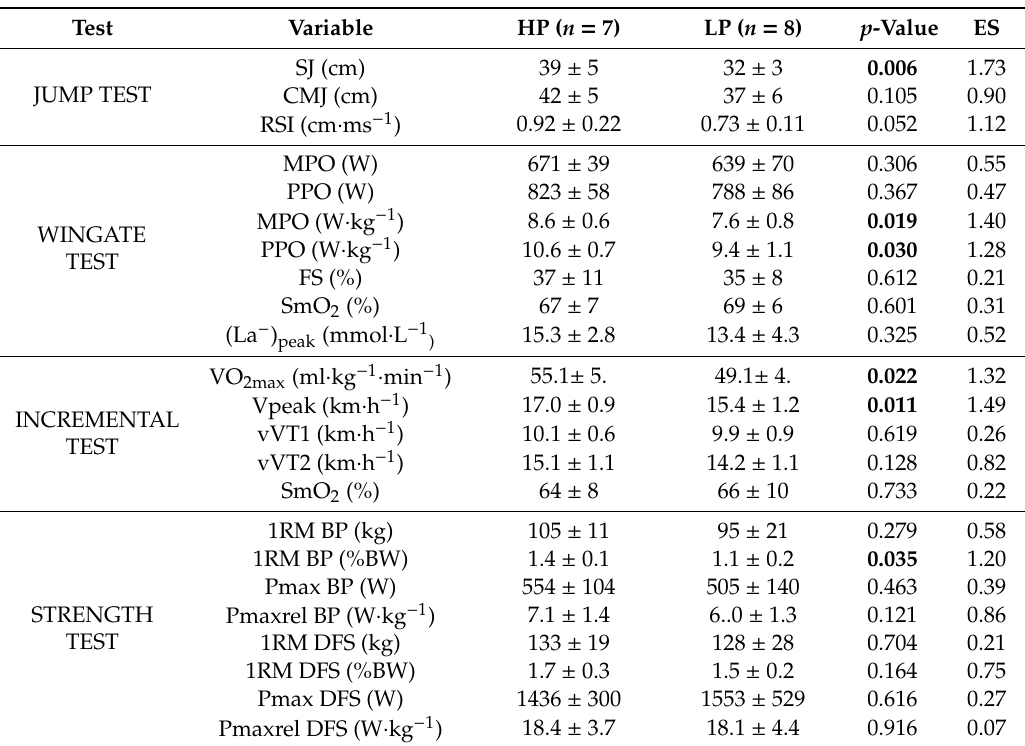
Table 2. Di ff erences between high (HP) and low-performance (LP)